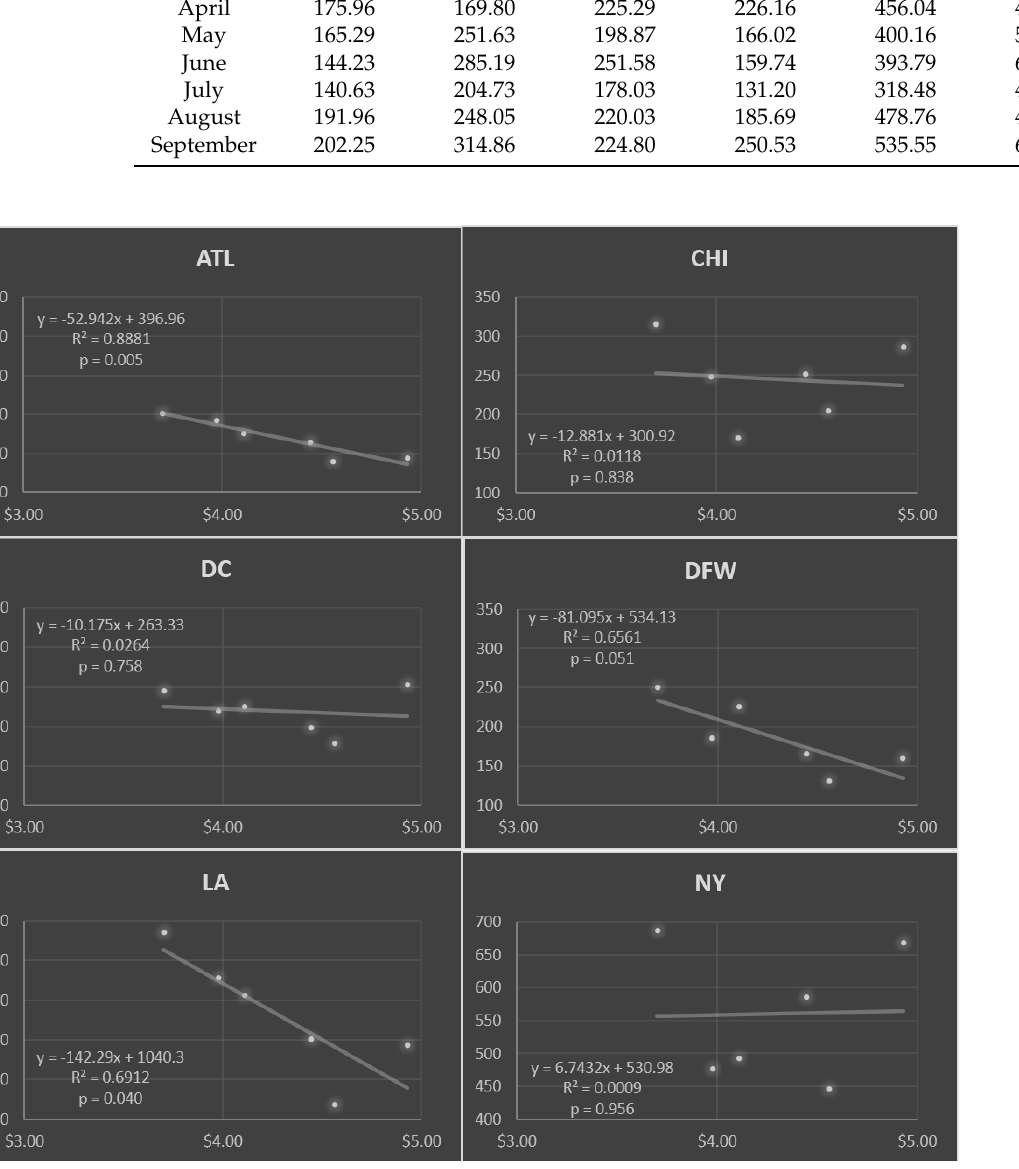
Figure 4. Monthly average gas prices in USD ( x -axis) vs. monthly average daily heavy traffic congestion amounts in mileHours ( y -axis).